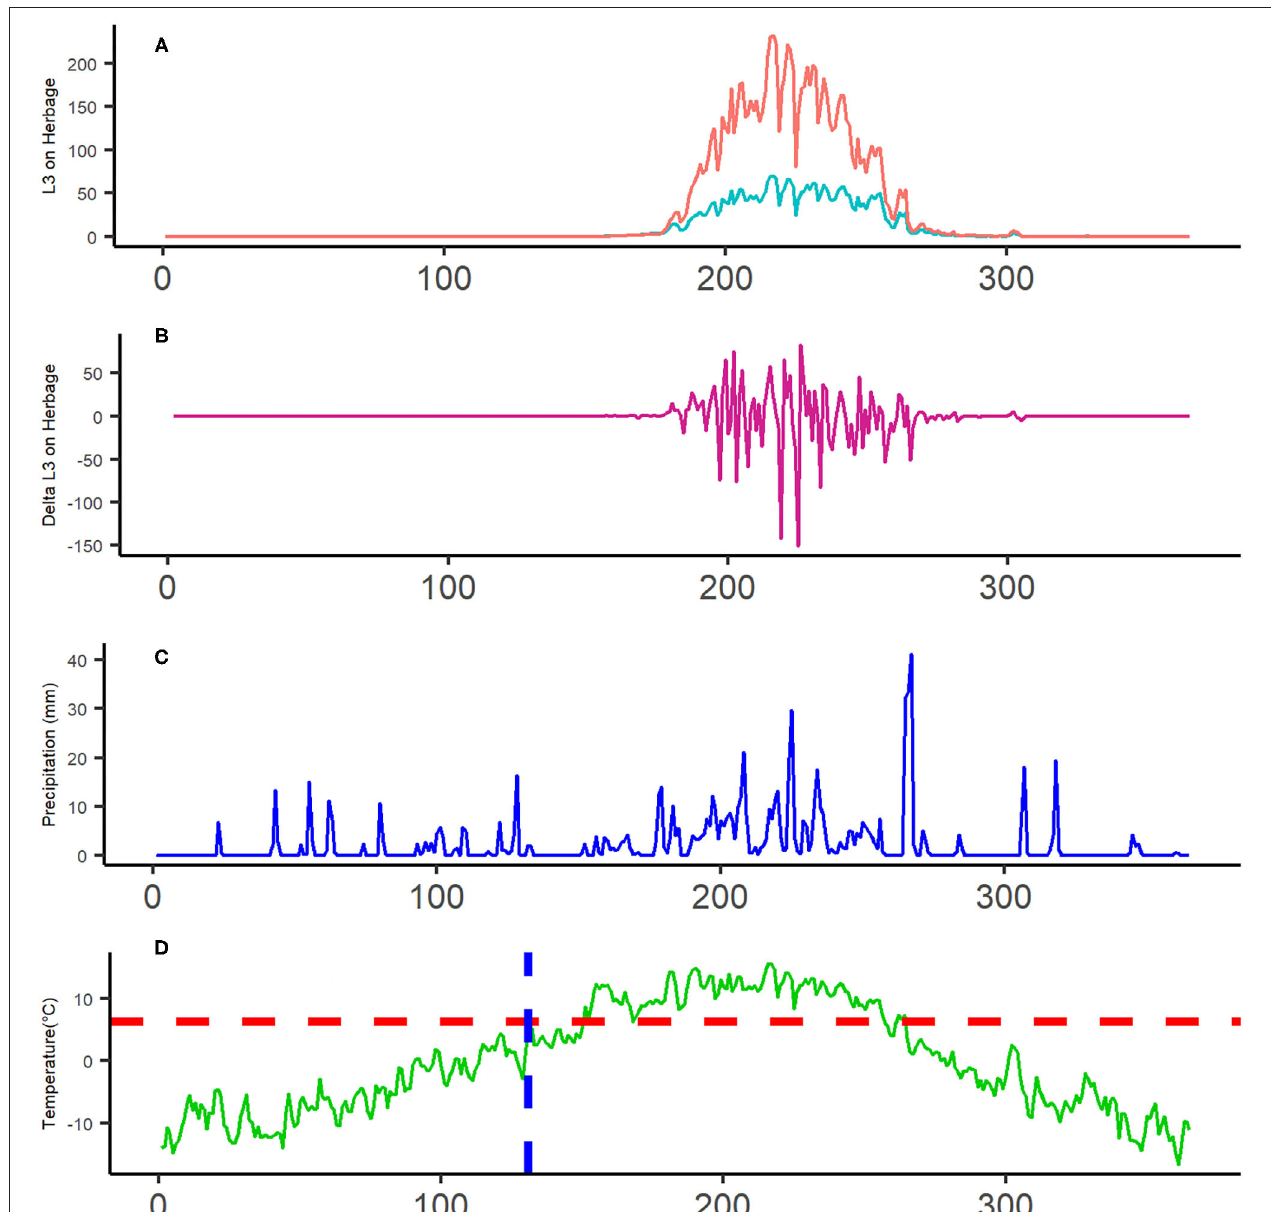
FIGURE 5 | Panel graph for disease transmission dynamics in Kibber in 2018. The x-axis for each graph is day with 0 2018; day 200 is late July. (A) GLOWORM-FL model output (number of L3 h per kilogramme of herbage) for individual hosts, Pink Daily change in L3 h per kilogramme of herbage, using the data in (A) . (C) The amount of precipitation (mm) on a given day in 2018. (D) the average temperature ( 0 C) on a given day in 2018. The vertical blue-dotted line on (D) indicates the first day on which larval development is possible, based on the lower development threshold of 6.6 ◦ C (horizontal red-dotted